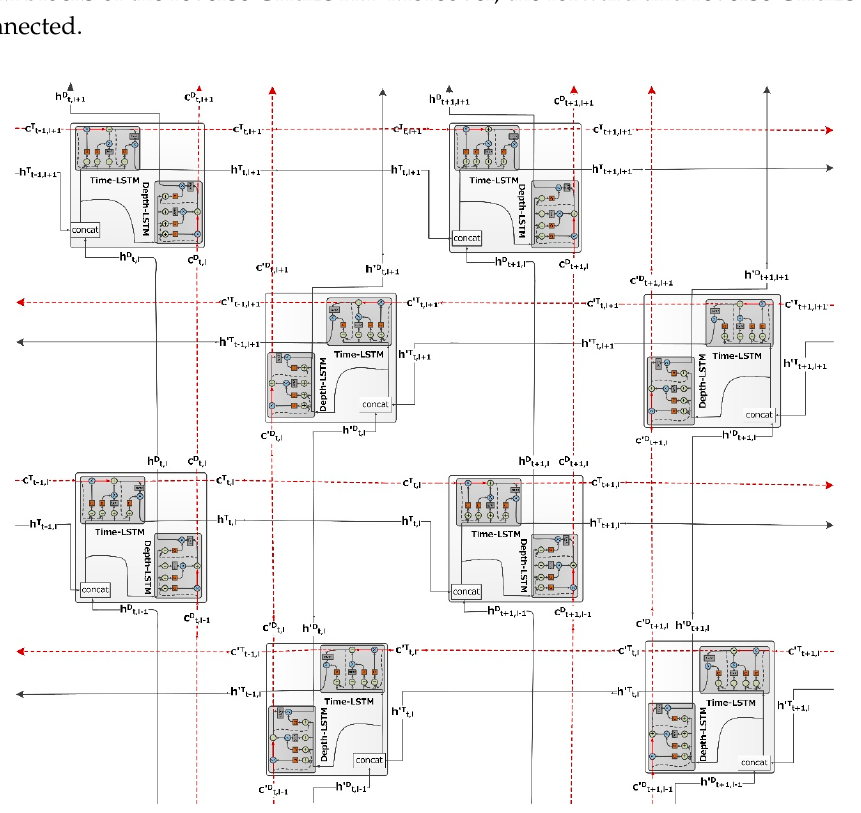
Figure 4. Bidirectional Grid LSTM expands in time. Symbol (cid:48) indicates reverse in